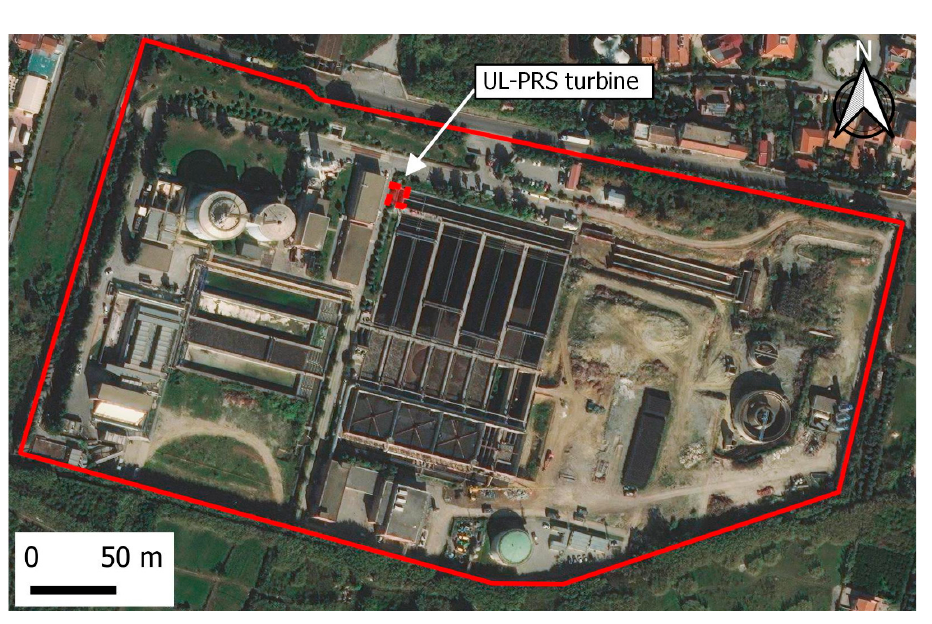
Figure 11. Acqua dei Corsari WWTP: Aerial view.